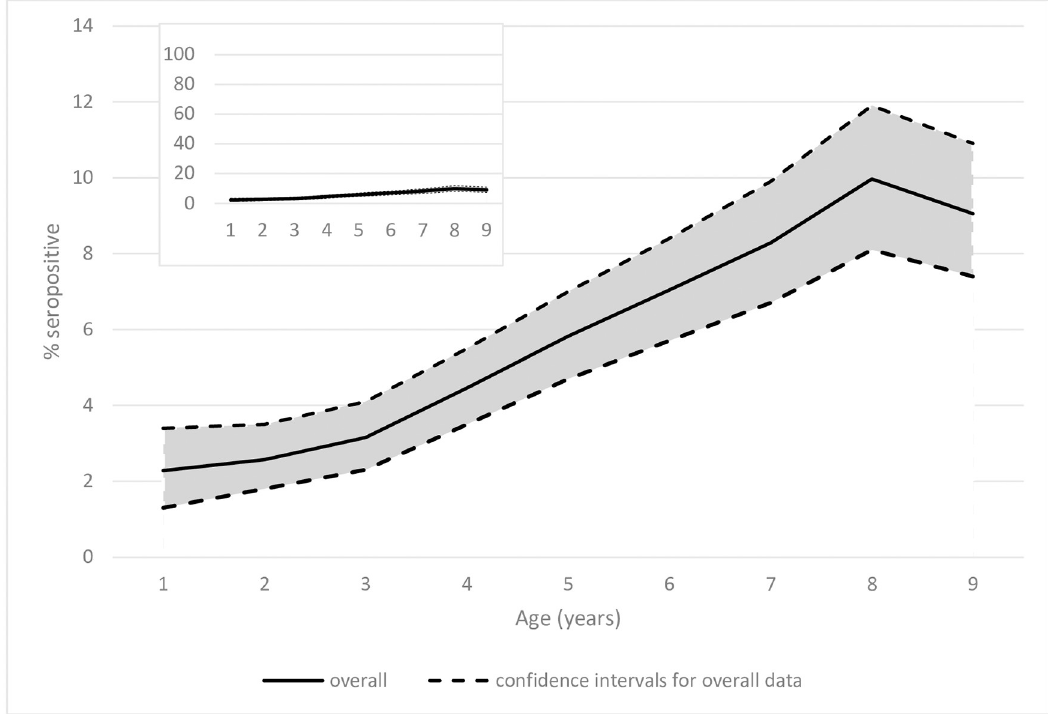
Fig 2. Seropositivity by age for the ELISA platform: Overall data 95%CI envelopes; inset graph shows the overall seropositivity by age using a 100% y-axis